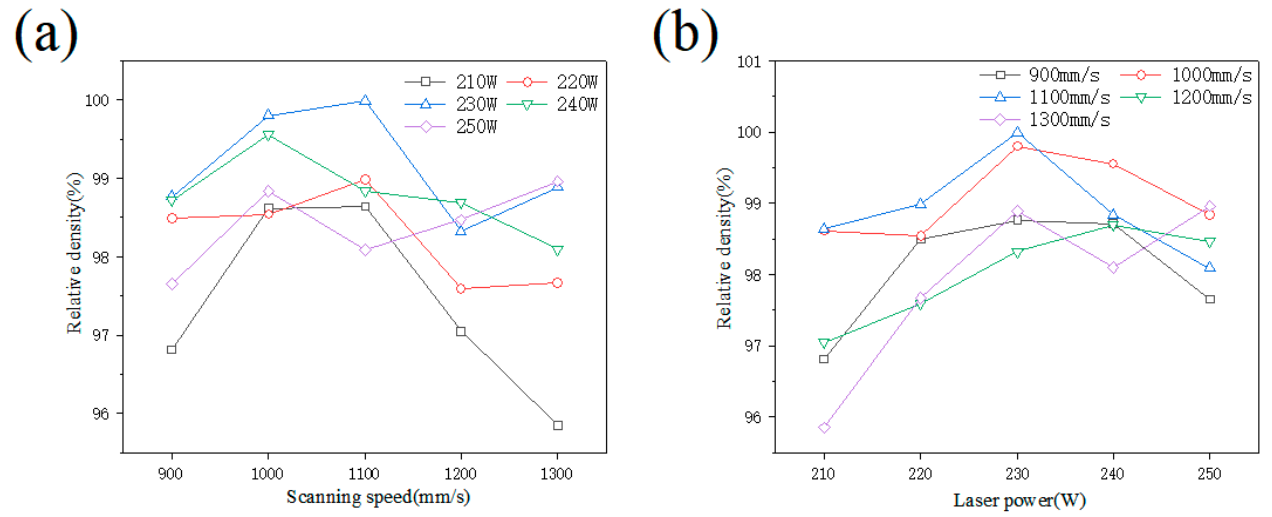
Figure 2. Variation in the sample’s relative density with the ( a ) scanning speed and ( b ) laser power.